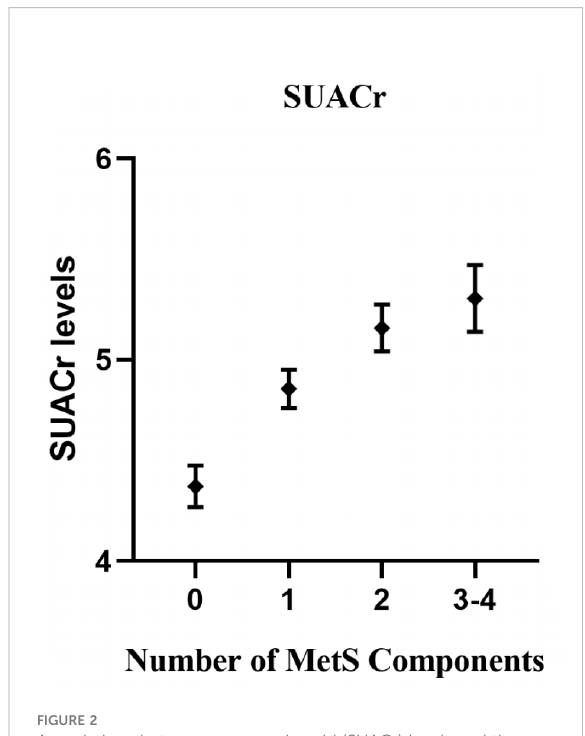
FIGURE 2 Associations between serum uric acid (SUACr) levels and the number of metabolic syndrome (MetS) components. The analysis of covariance (ANCOVA) model included the levels of SUACr as the dependent variables, and the number of MetS components as a fi xed factor. Adjusted confounders were age, gender, smoking and drinking status, and